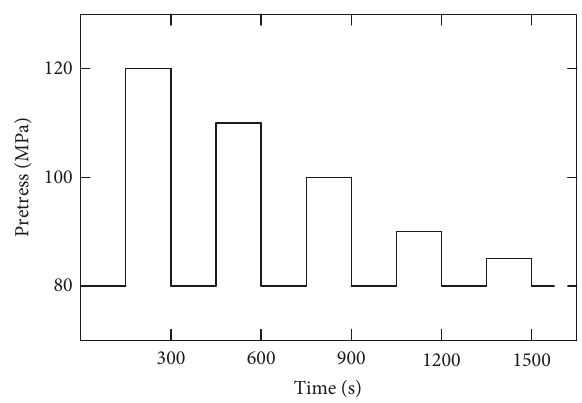
Figure 6: The prestress curve for stress detection resolution study.